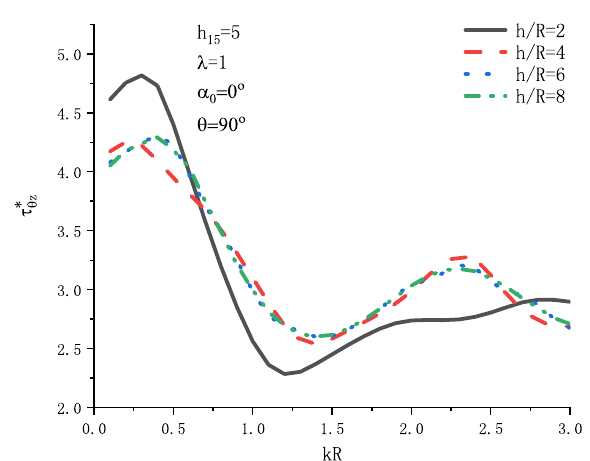
R when incident frequency kR = 1 . (cid:31)